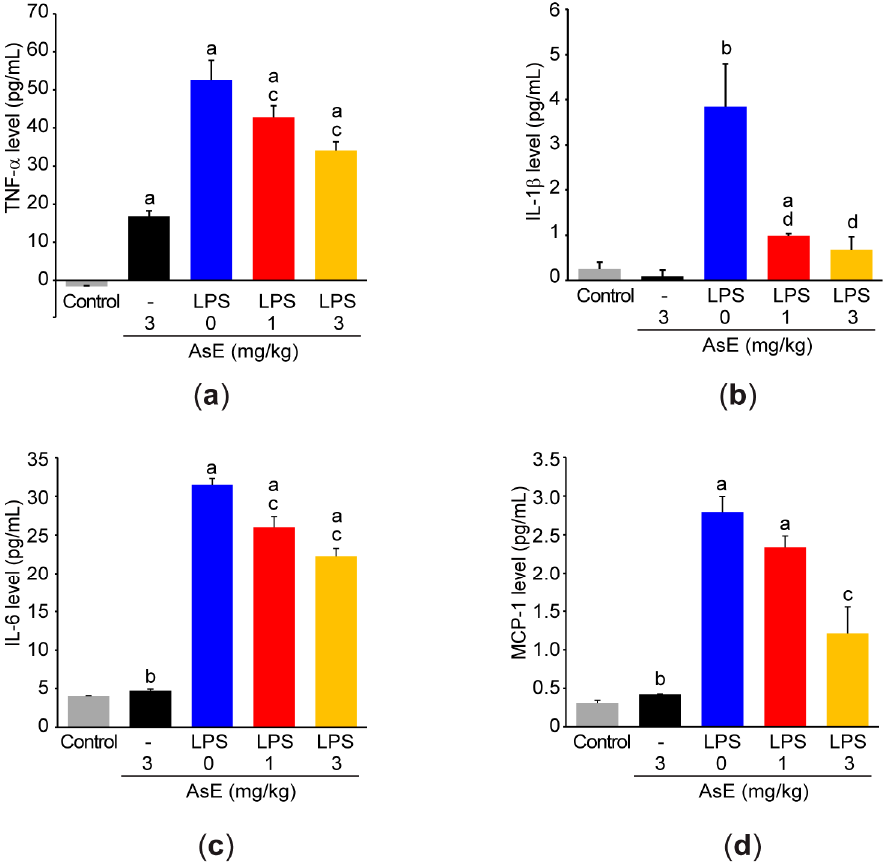
Figure 6. AsE reduces proinflammatory cytokine production in LPS-stimulated Raw264.7 cells. Raw264.7 cells were treated with AsE and LPS, as described in Figure 5b. Levels of TNF- α ( a ), IL-1 β ( b ), IL-6 ( c ), and MCP-1 ( d ) were quantified in the conditioned medium. a p < 0.01, b p < 0.05 versus control cells; c p < 0.01, d p < 0.01 versus LPS-treated cells; MCP-1, monocyte chemoattractant protein-1; TNF- α , tumor necrosis factor- α